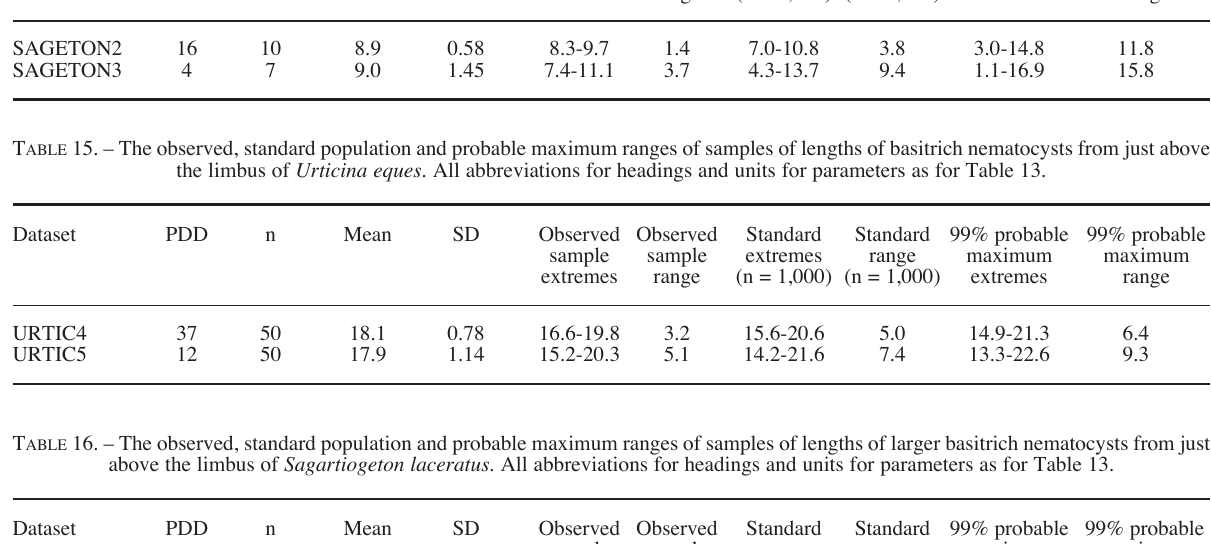
Table 14. – The observed, standard population and probable maximum ranges of samples of lengths of smaller basitrich nematocysts from just above the limbus of Sagartiogeton laceratus . All abbreviations for headings and units for parameters as for Table 13.